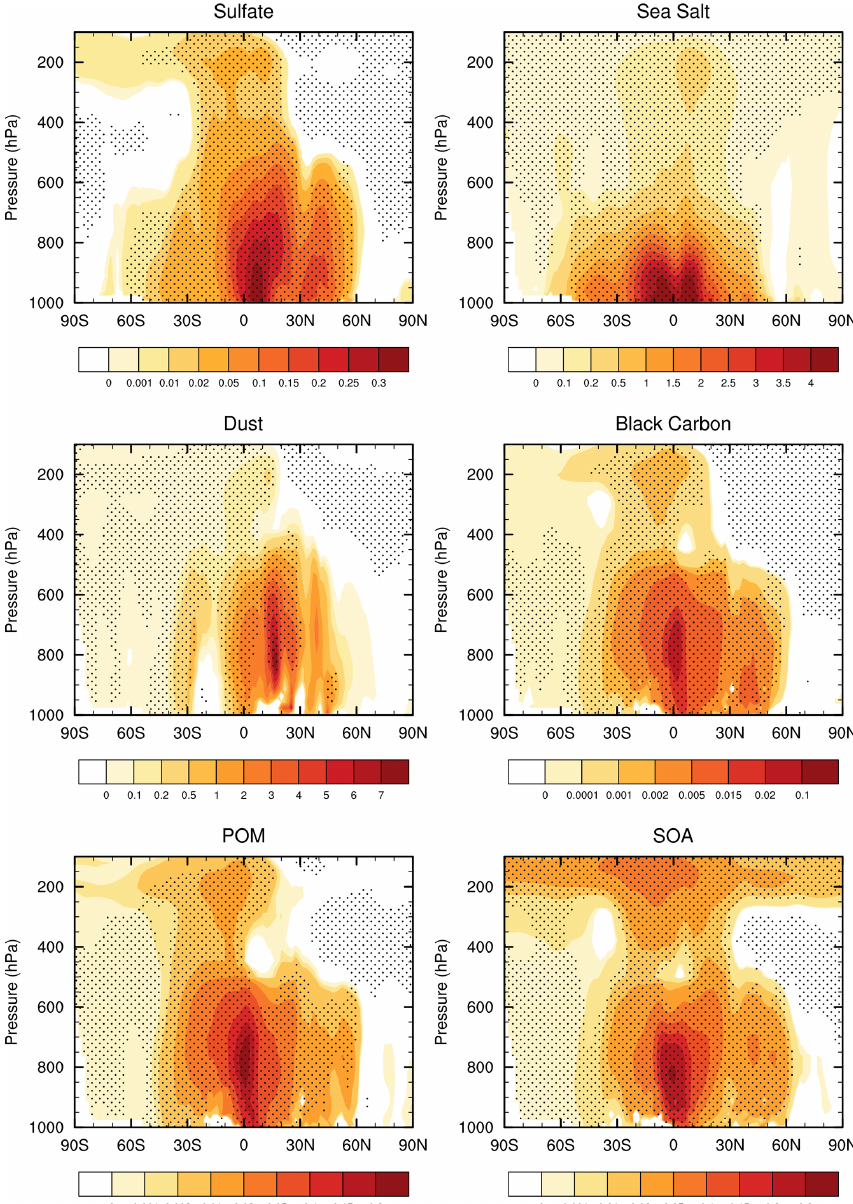
Figure 13. Annual and zonal mean cross sections of changes in different aerosol mass concentrations (µg/kg) between STOC and CAM5 runs (STOC–CAM5). Areas exceeding the 95% t -test confidence level are